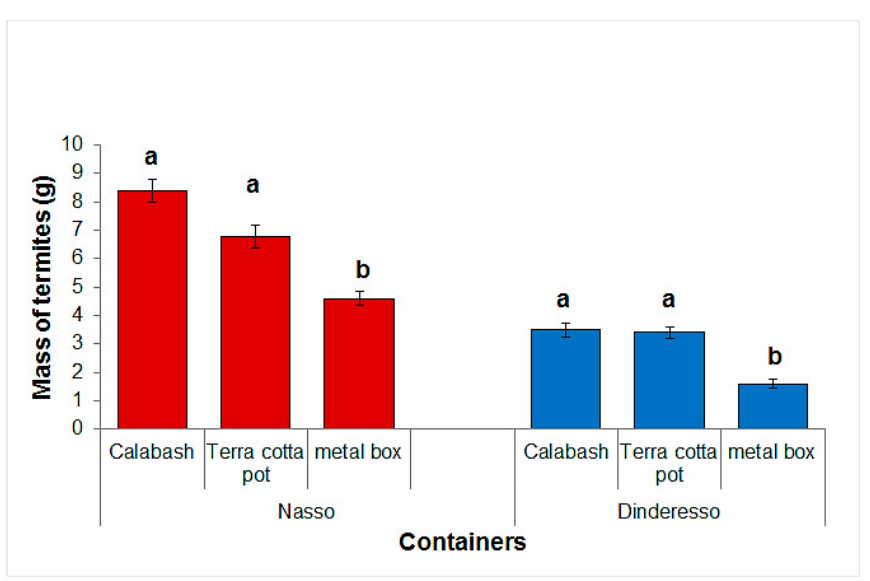
Figure 4. Average masses of dry termites harvested per container, according to container’s type and site. The histograms represent the averages of 20 replicates and those with the same letters at the same site are not significantly different at the 5% level. Error bars represent standard errors.